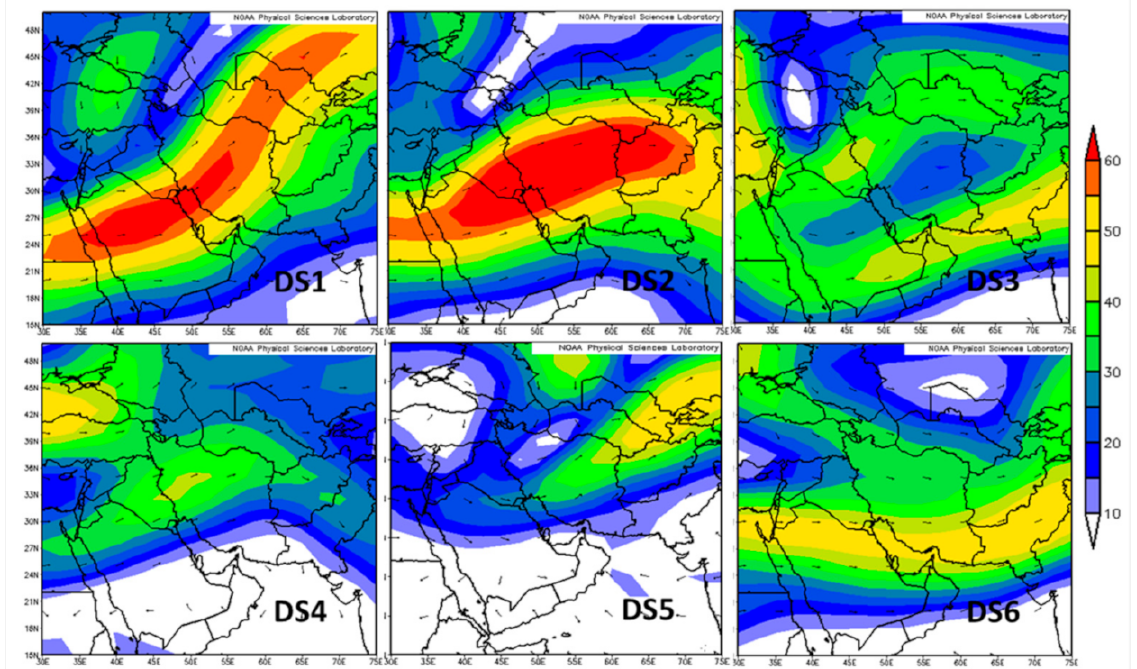
Figure 3. Synoptic maps of the vector winds at 300 hPa (in ms − 1 colored scale) taken from National Center for Envi- ronmental Prediction/ National Center for Atmospheric Research (NCEP/NCAR) reanalysis on 17 February 2017 (DS1), 1 February 2017 (DS2), 19 January 2018 (DS3), 30 October 2017 (DS4), 1 October 2016 (DS5) and 9 December 2016